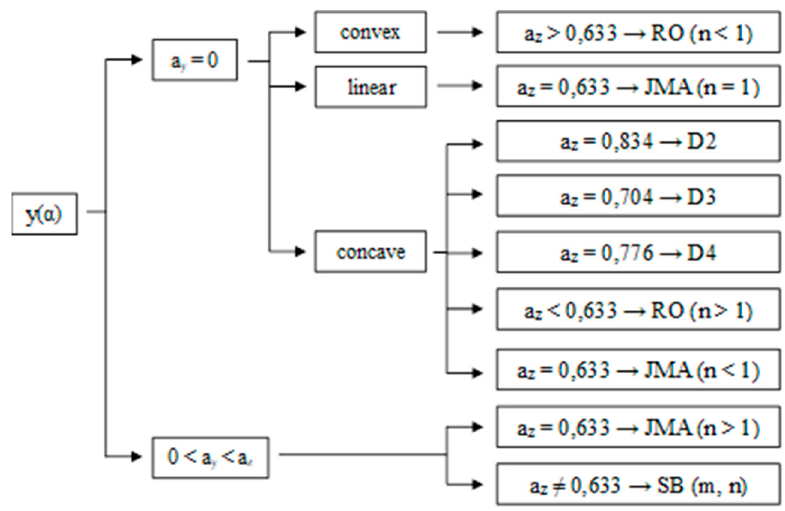
Figure 1. Schematic diagram of kinetic models using y ( α ) and z ( α ) functions [17].